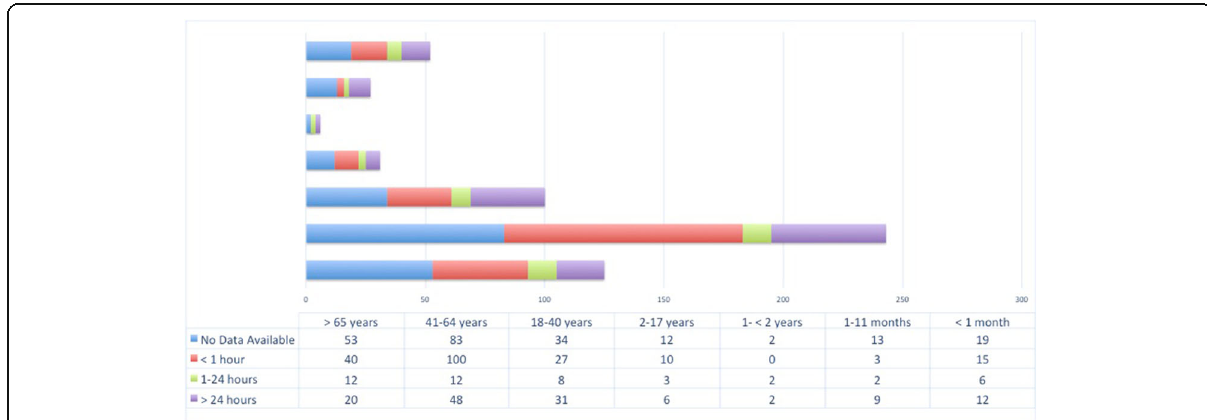
Fig. 1 Onset time of symptoms before death by age